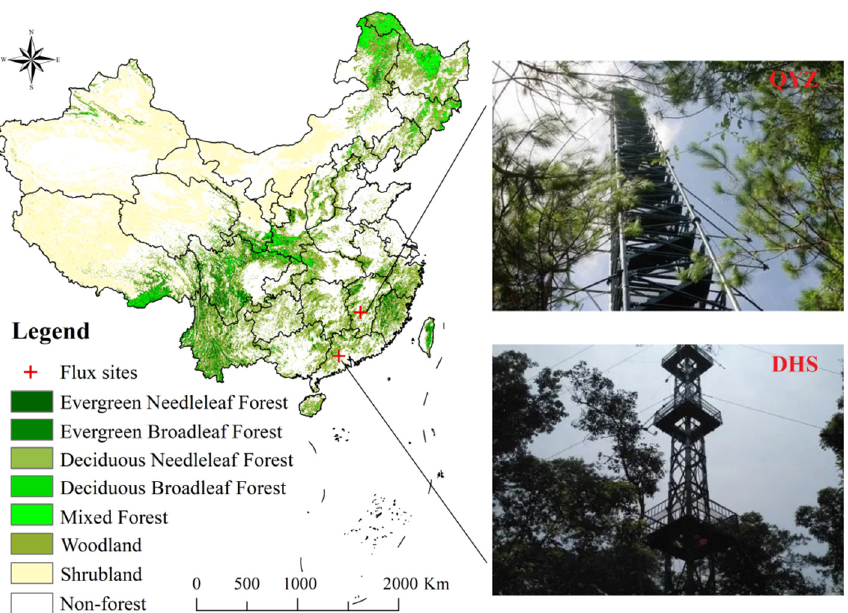
Figure 1. Geographical location of the two subtropical forest flux sites (QYZ and DHS) used in the present study. The base map is derived from AVHRR 1 km land-cover map.